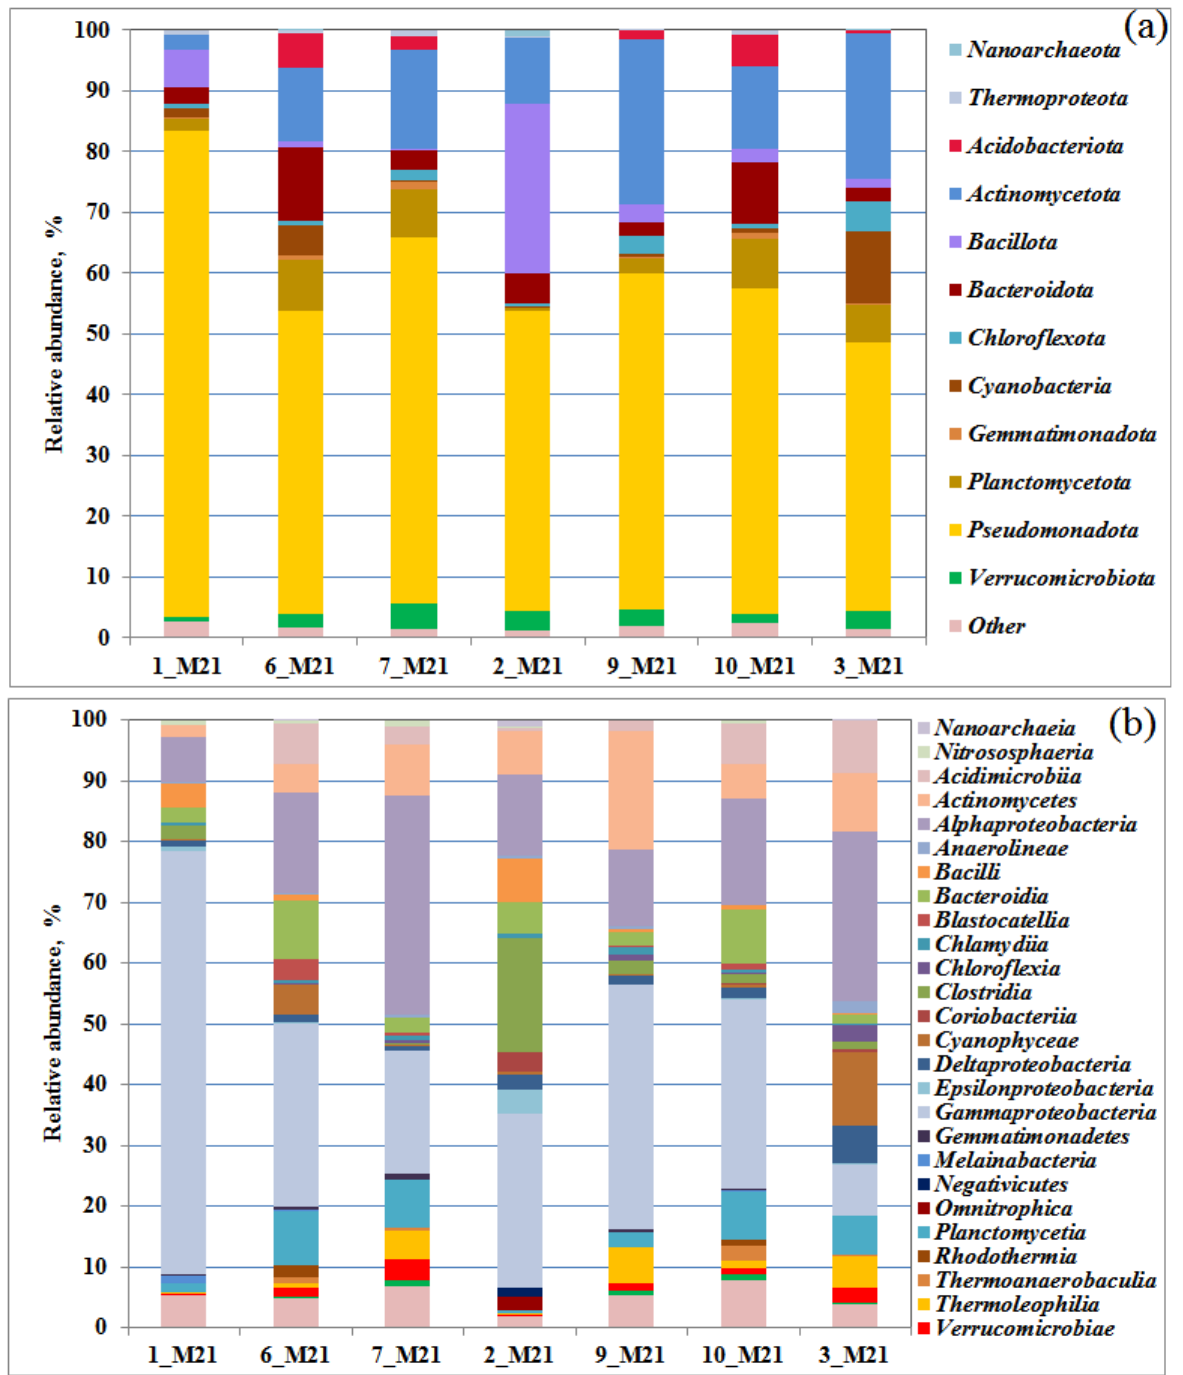
Figure 2. Relative proportion of bacterial 16S rRNA gene sequences presented at the phylum ( a ) and class level ( b ) in the libraries from seawater, littoral, and coastal soil samples. Bacterial taxa constituting >1% in at least one library are listed.